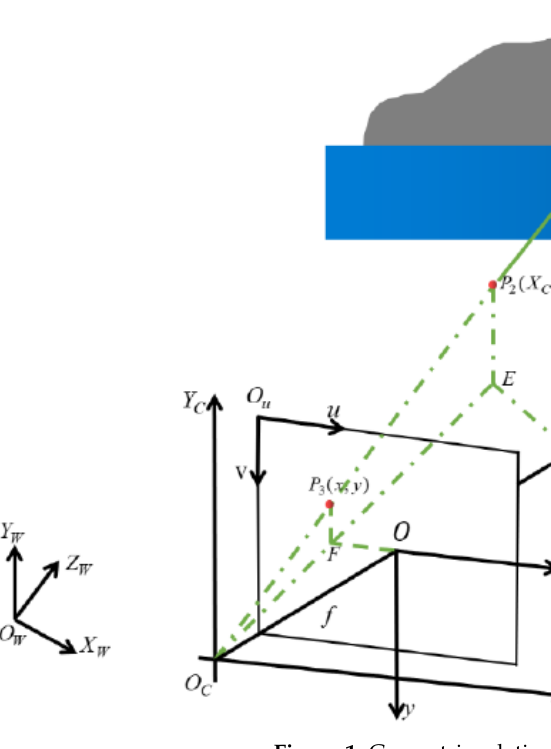
Figure 1. Geometric relations in coordinate system